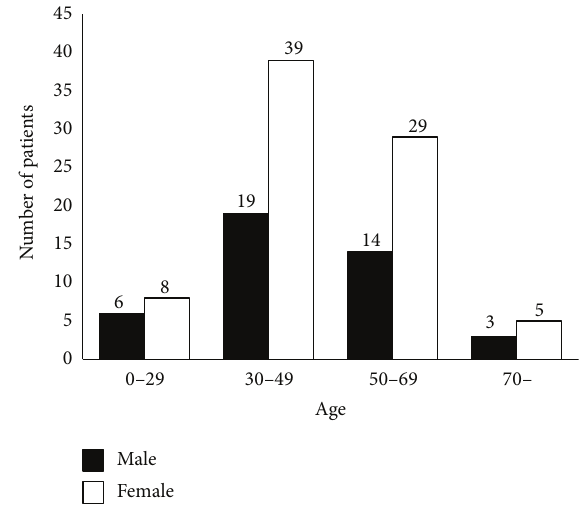
Figure 1: The sex and age distributions of the patients. Total 123 patients (42 males and 81